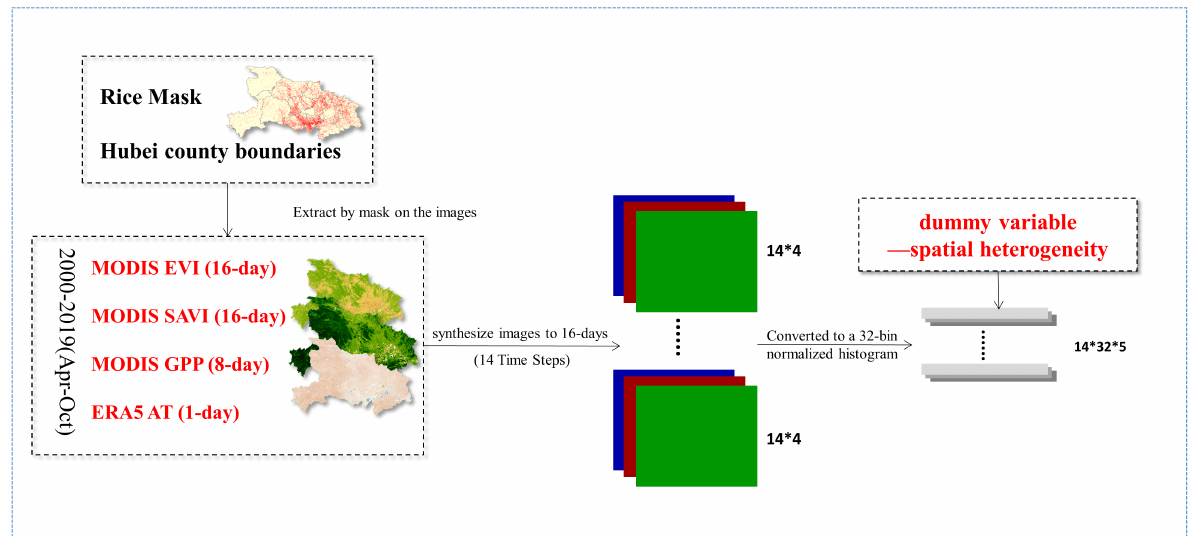
Figure 2. GEE processing